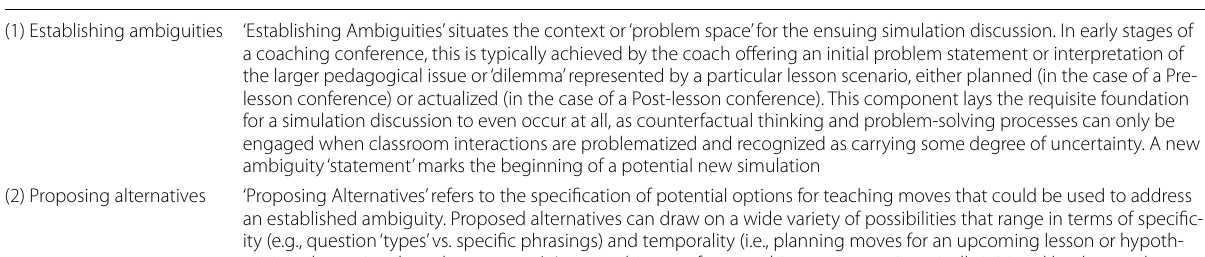
Table 1 MSTR components and descriptions MSTR component